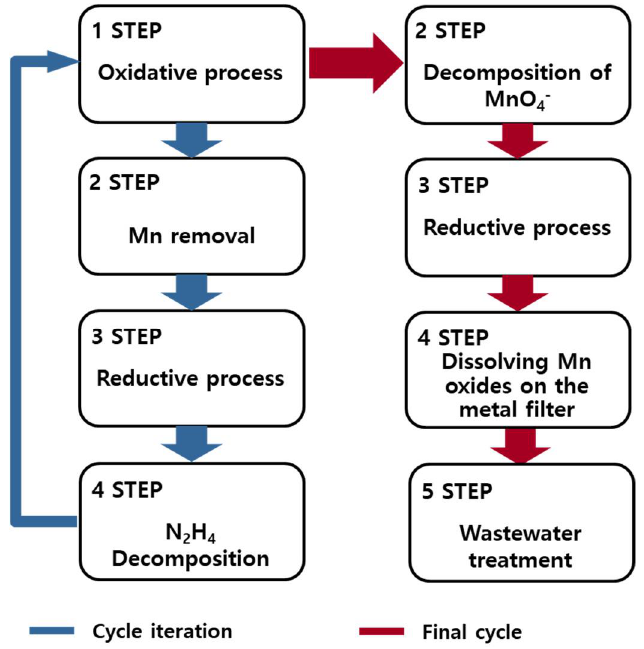
Figure 1. Flow diagram of the SP-HyBRID process.